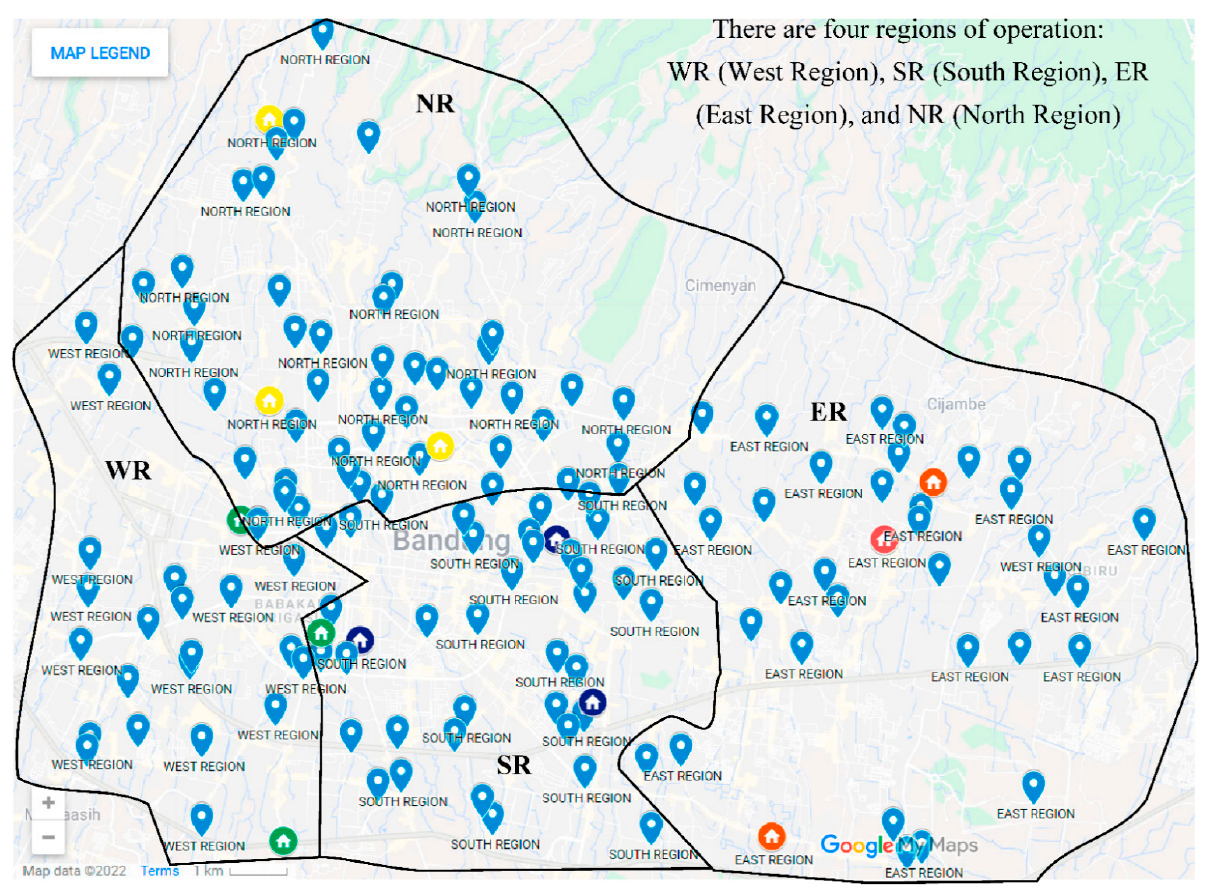
Figure A2. Bandung city map and waste collection locations.